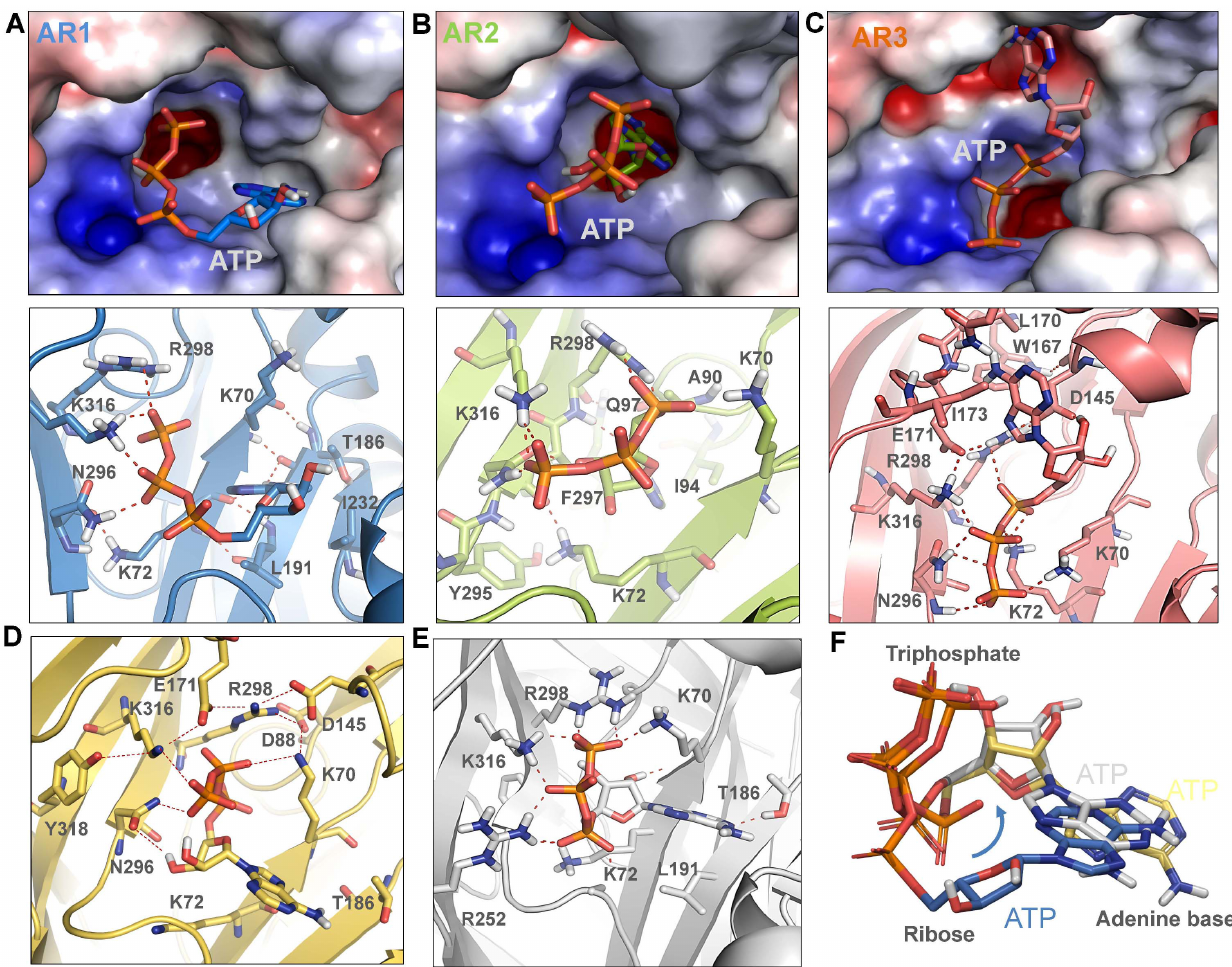
Figure 2. Three distinct potential ATP-recognition modes of zfP2X4 receptors. ( A–C ) Structure and key residues (displayed in sticks for emphasis) of three distinct potential ATP-recognition (AR) modes of zfP2 X 4 receptors: AR1 ( A ), 2( B ) and 3( C ). ATP was docked into the potential binding sites, S1, 2 and 3, of zfP2 X 4 using docking program Glide [34]. ( D ) AR1 mode obtained by docking ATP into previously sampled/averaged zfP2 X 4 structure by 2-ns MD simulations. ( E ) AR1 mode obtained by induced fit docking strategy. ( F ) Superposition of ATP poses of AR1 modes obtained by three different strategies, including rigid body docking ATP into static closed structure of zfP2 X 4 (blue) and previously sampled/ averaged closed structure of zfP2 X 4 (yellow) by 2-ns MD simulations, and induced fit docking (grey).